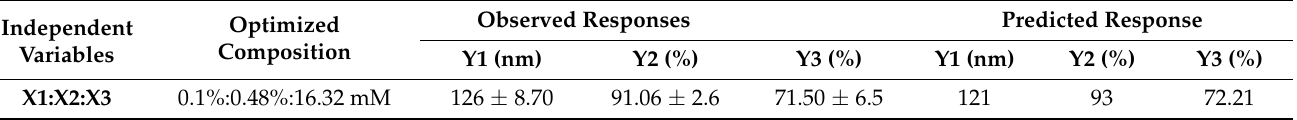
Table 4. Optimum composition of independent variables, observed vs. predicted responses in BBD of β